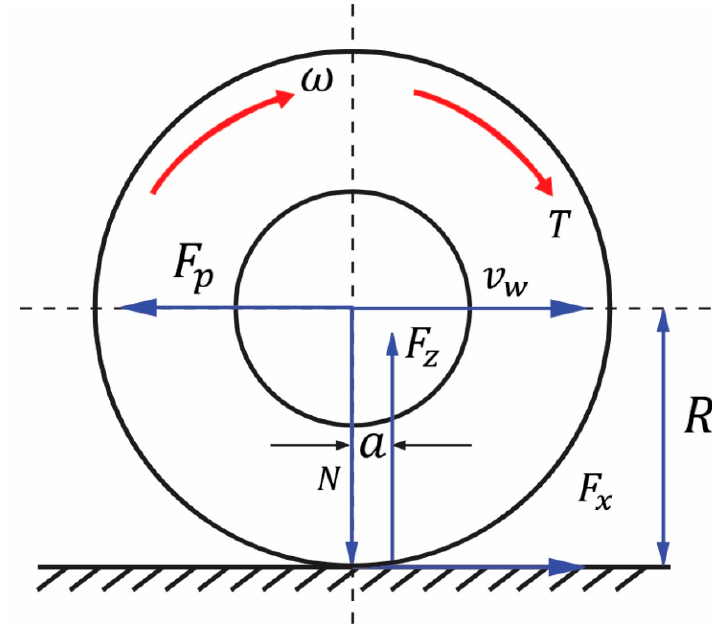
Figure 2. Wheel force system schematic [22].